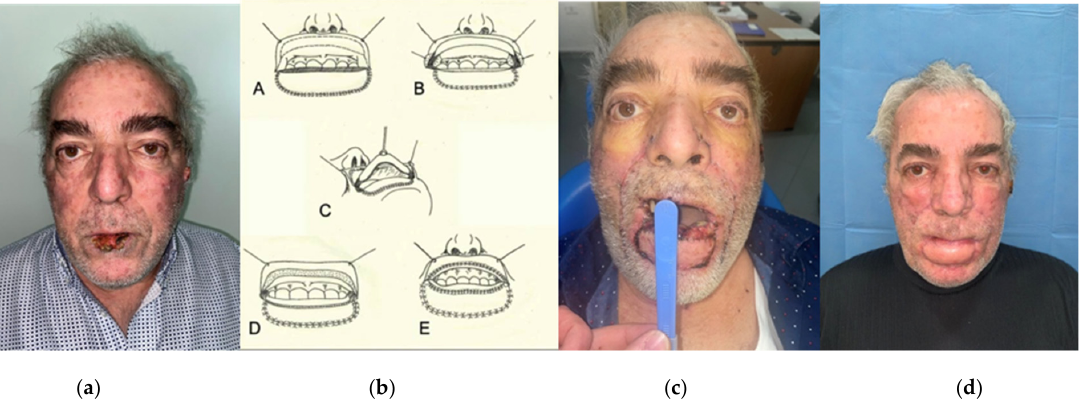
Figure 3. ( a ) Carcinoma of lower red lip mucosa involving the skin (stage IV), ( b ) Surgical planning with the Bernard/Gupta flap, ( c ) photograph of the patient 2 days after surgery, ( d ) photograph of the patient 4 weeks after surgery.